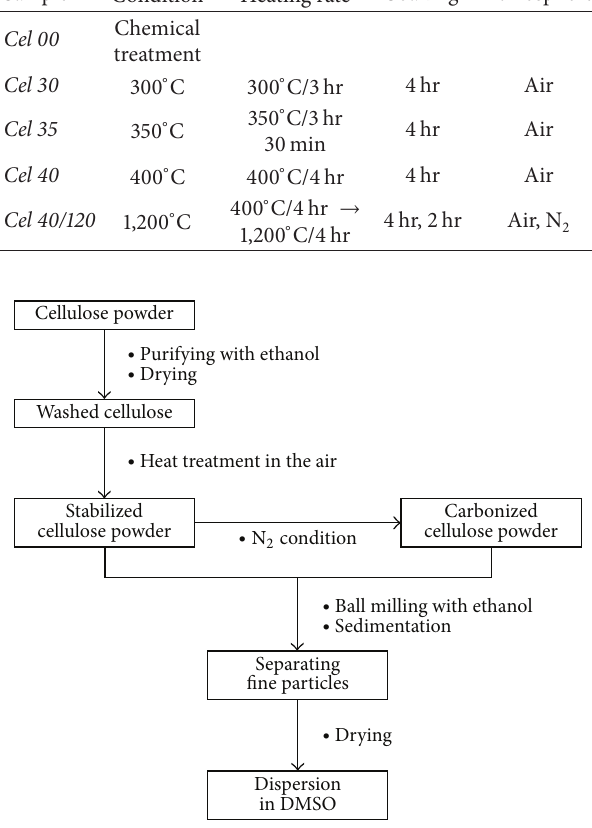
Figure 1: Preparation of the cellulose dispersed PAN